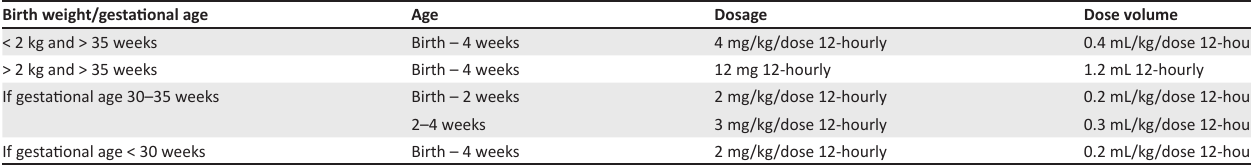
TABLE 2: Zidovudine doses for post-exposure prophylaxis